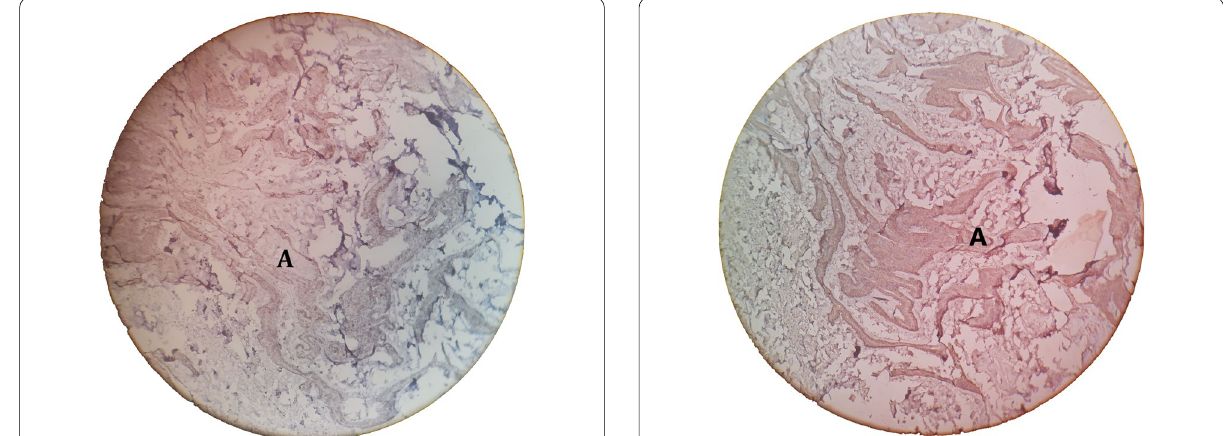
Fig. 13 IHC 40 image; showing pankeratin positivity seen in cyst × wall lining epithelium shown as ‘A’